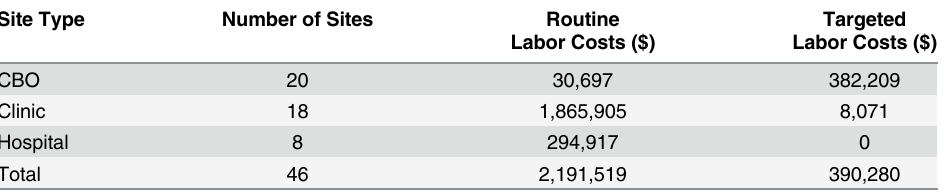
Table 2. Routine and Targeted Labor Costs by Site and Test